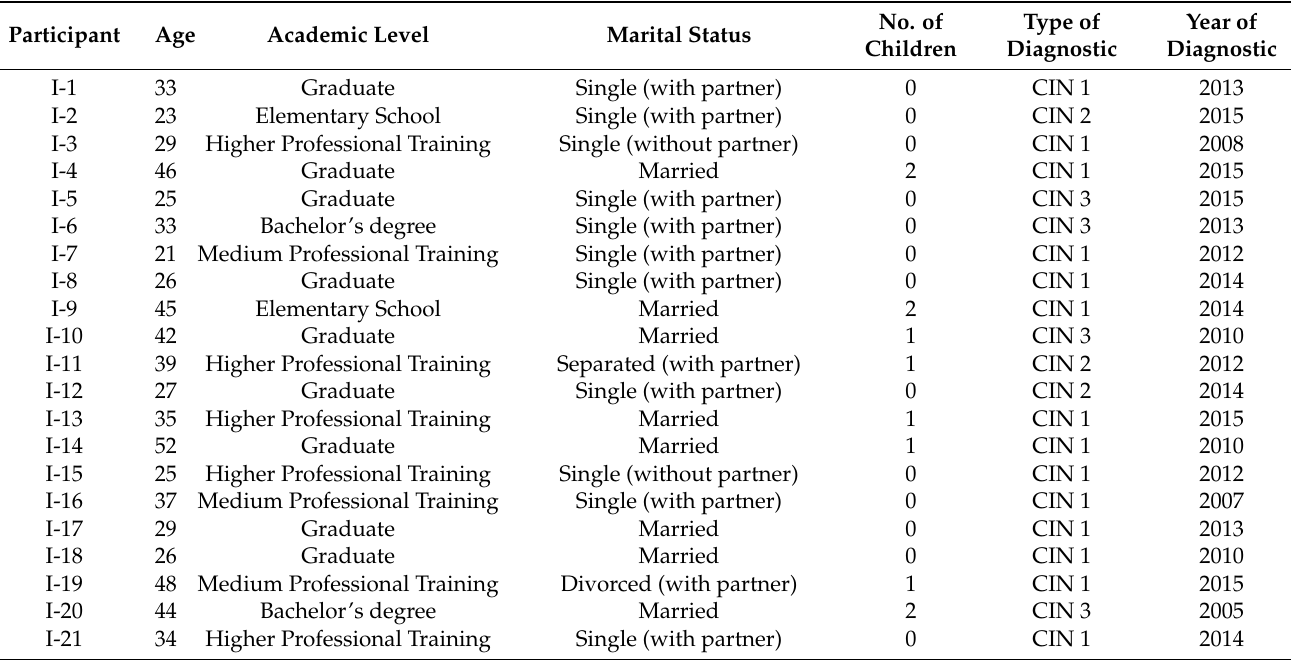
Table 1. Sociodemographic